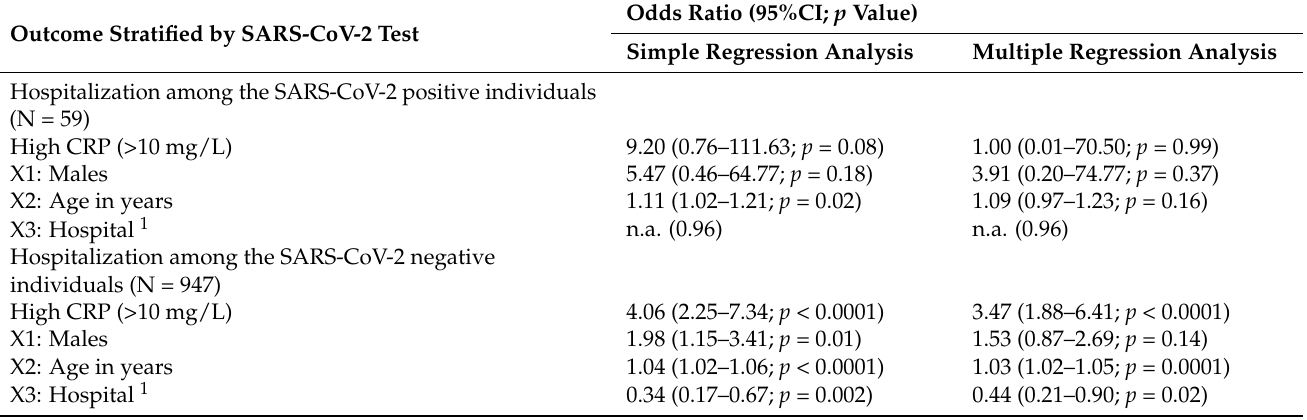
Table 3. Odds ratios (95% confidence intervals) and p values for hospitalizations stratified by the results of the SARS-CoV-2